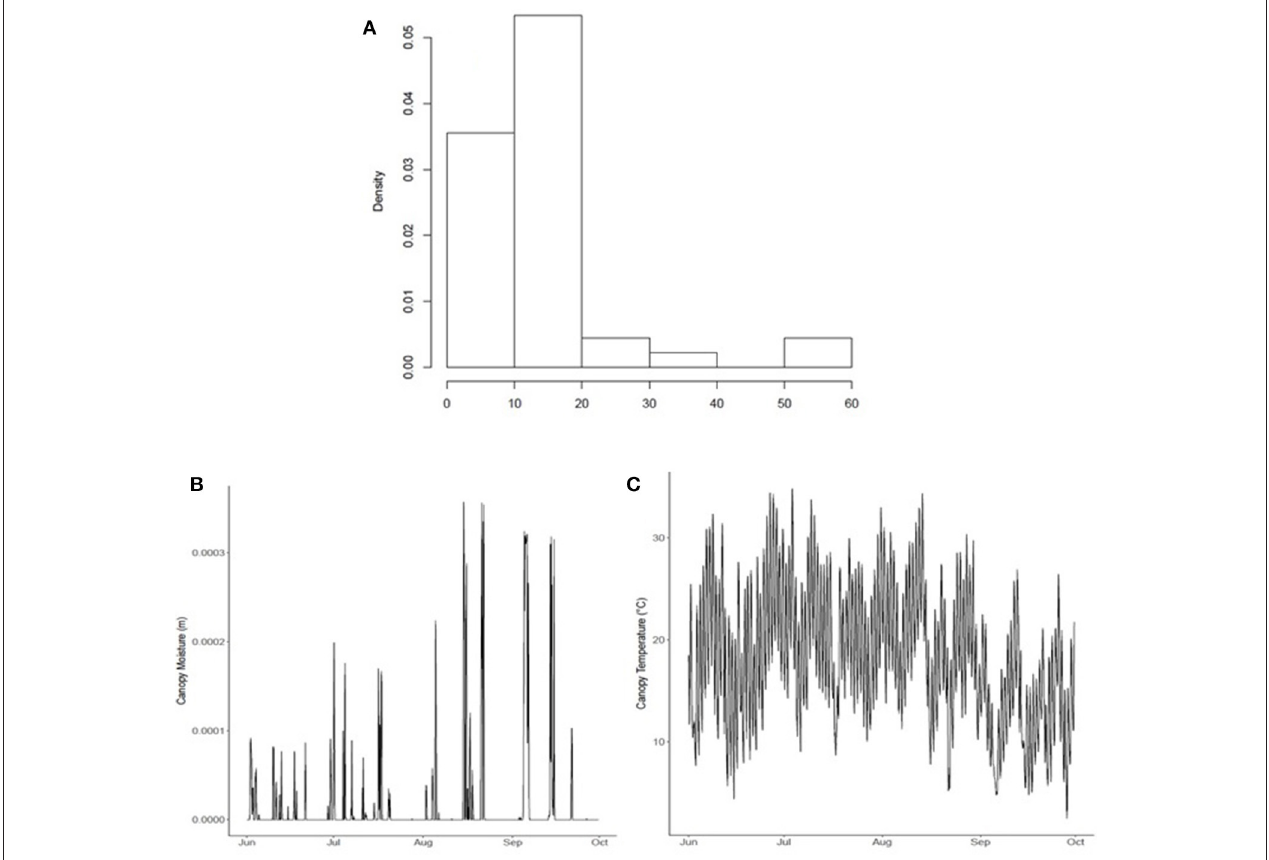
FIGURE 4 | (A) Growing season wetness duration (h) distribution, (B) canopy wetness (m), and (C) temperature ( o C) within the modeled ROI comprising 40 townships within the 2015 growing season, surrounding the Lethbridge site.